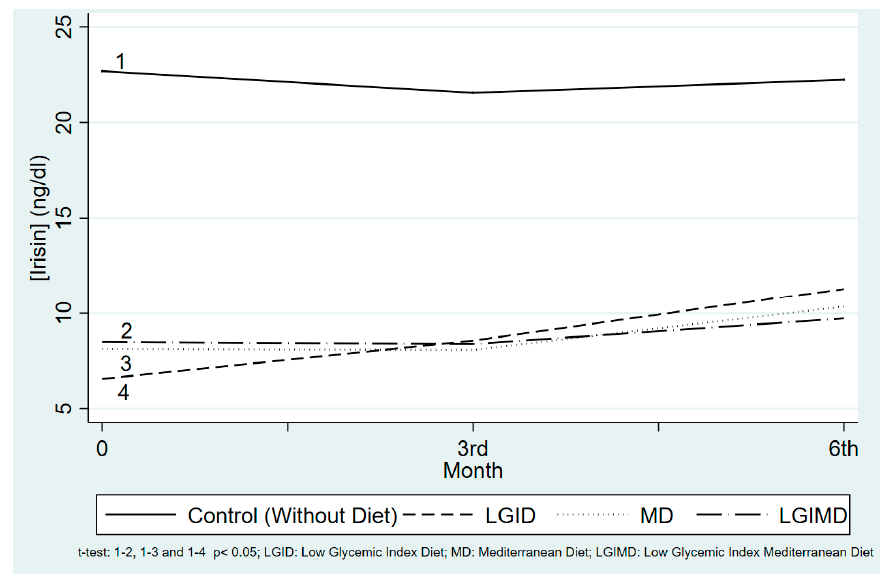
Figure 1. Observed irisin Concentrations by Diet and Time. Medidiet Trial, Castellana Grotte (Italy). t -test statistic.